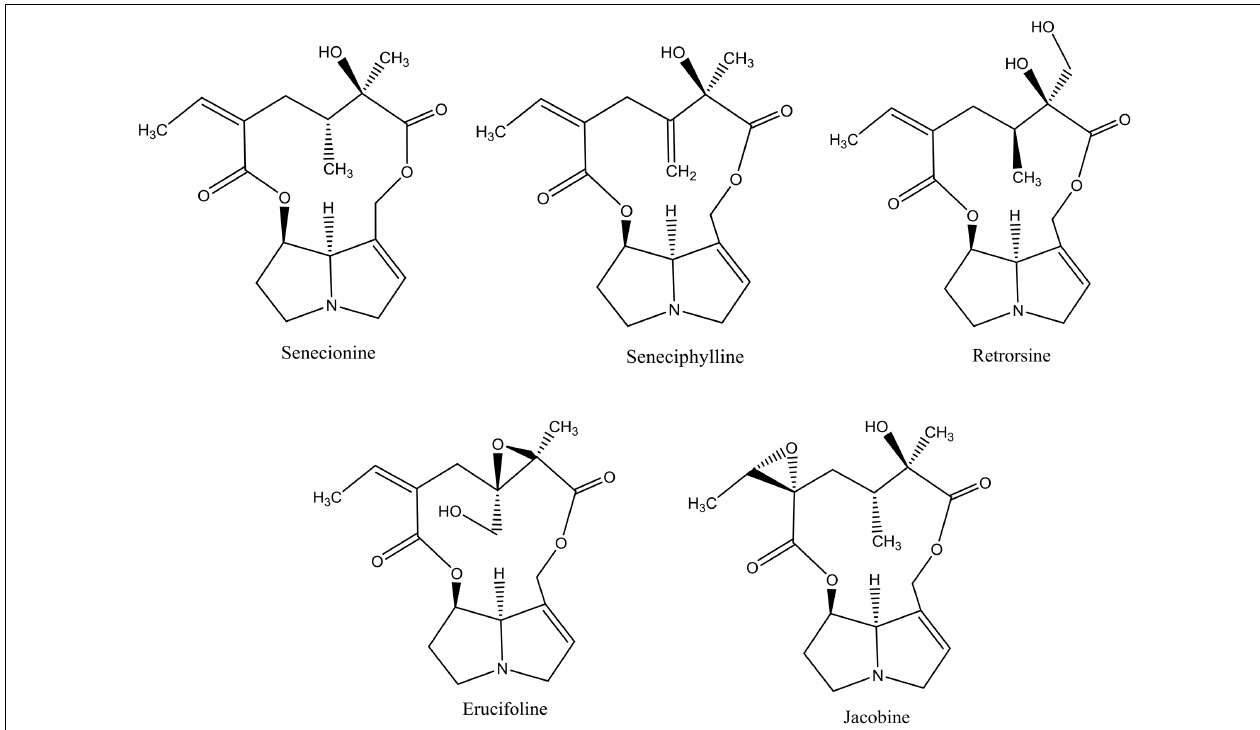
FIGURE 1 | The chemical structures of pyrrolizidine alkaloids (PAs) used in this study. All PAs are depicted as free bases.